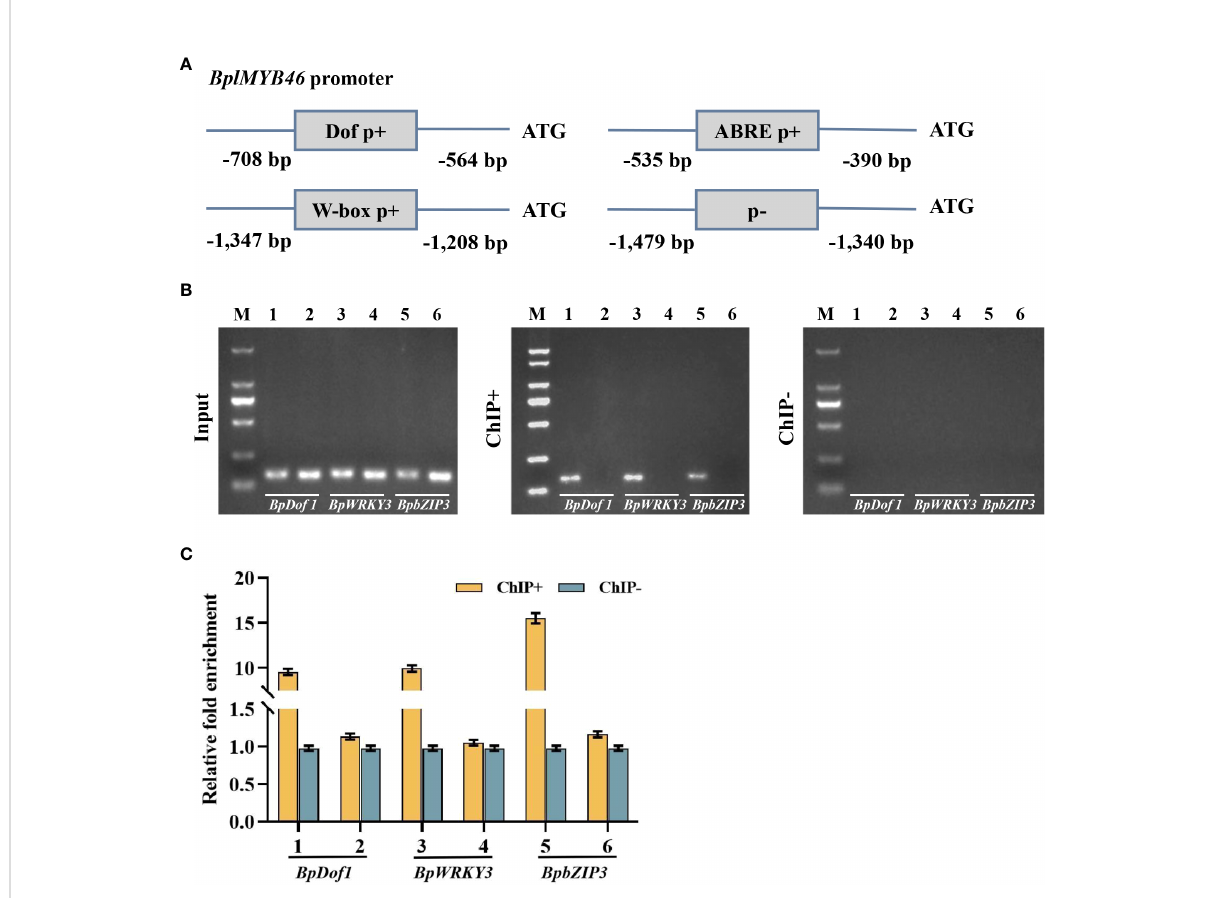
FIGURE 6 The upstream regulatory factors of BplMYB46 speci fi cally binding to the Dof, W-box, and ABRE elements according to ChIP assays. (A) Positions of truncated BplMYB46 promoters containing and lacking the Dof element. Dof p+, W-box p+, and ABRE p+: truncated BplMYB46 promoter containing three copies of the Dof element, two copies of the W-box element, and two copies of the ABRE element, respectively. p-: truncated BplMYB46 promoter without Dof, W-box, and ABRE elements. (B) ChIP products obtained from the promoter of BplMYB46 analyzed by gel electrophoresis after PCR ampli fi cation. M: DL2000 Marker (from top to bottom: 2 kb, 1 kb, 750 bp, 500 bp, 250 bp, and 100 bp). (C) Real-time quantitative PCR analysis showing the enrichment of the promoter sequence of BplMYB46 after ChIP. Input, Input DNA (positive control); CHIP+: chromatin immunoprecipitation with anti-GFP antibody; CHIP − : chromatin immunoprecipitation without antibody (negative control). 1: Dof p+, 3: W-box p+, 5: ABRE p+, 2, 4, 6: